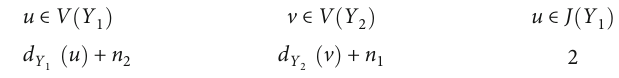
Table 1: The degree distribution of Y